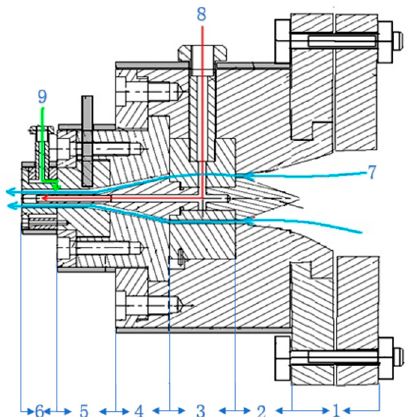
Figure 3. Structural diagram of the die. 1 —Melt inlet section; 2 —Melt split section; 3 —Melt advective section; 4 —Melt compressive section; 5 —No gas-assisted forming section; 6 —Gas-assisted forming